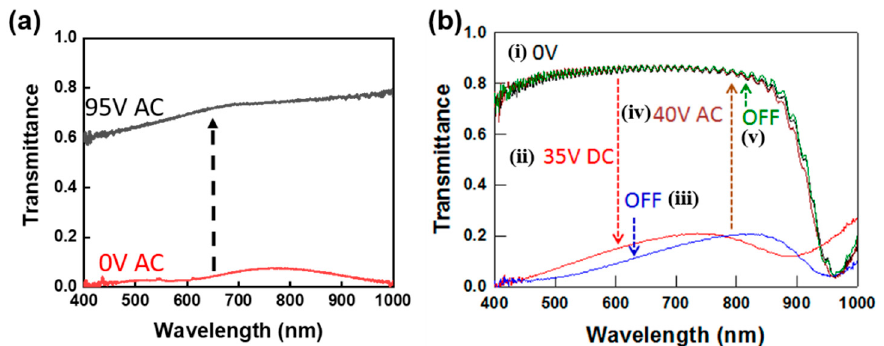
Figure 3. Switchable LC devices in ( a ) normal mode which is focal conic at 0 V and switches to a transparent homeotropic state when 95 V AC is applied. ( b ) Reverse mode switchable CLC that is (i) in the transparent planar state at 0 V, (ii) switches to the scattering focal conic state with 35 V DC, (iii) is stable in the focal conic state when the DC voltage is removed, (iv) switches back to the transparent planar state upon application of 40 V AC, and (v) remains stable in the planar state when the voltage is stable.